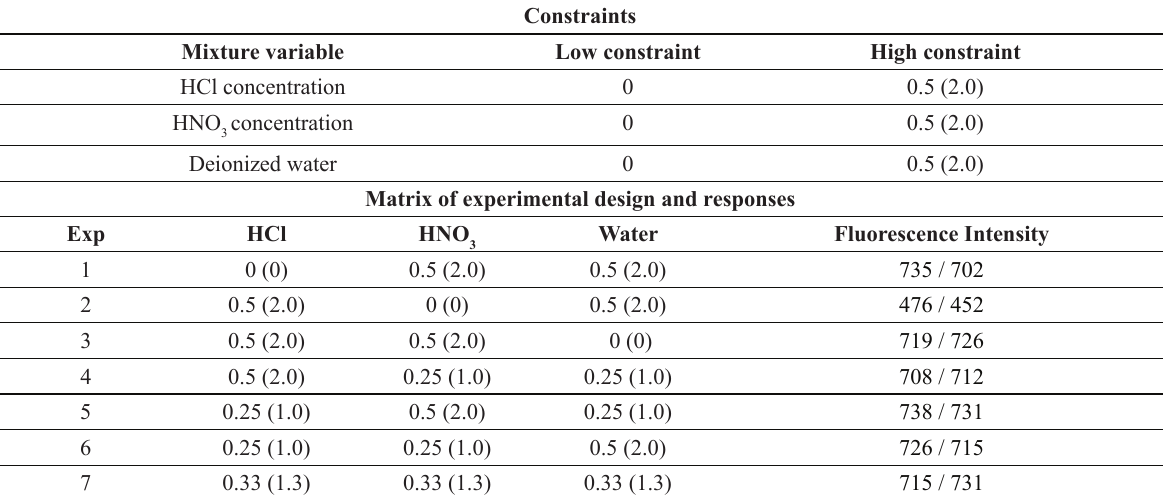
Constraints for the mixture components and results in terms of fluorescence intensity.